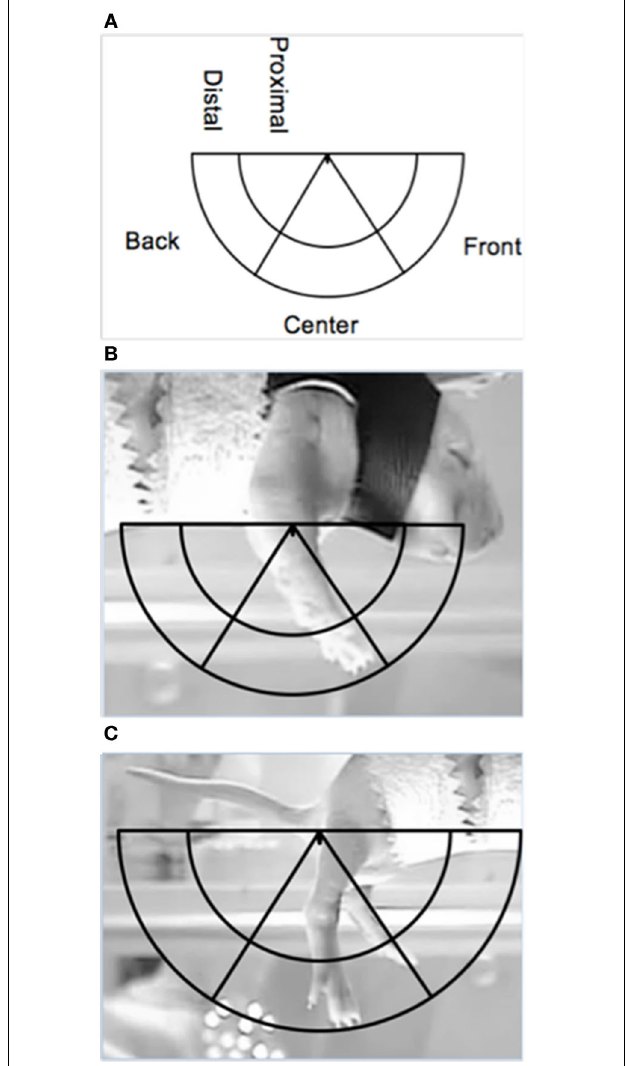
FIGURE 2 | Depiction of the limb trajectory space with the different limb trajectory areas labeled (A) along with illustrations of the placement of the trajectory area on proximal points for the (B) forelimbs and the (C) hindlimbs (the ventrum of the pup and the base of the tail,